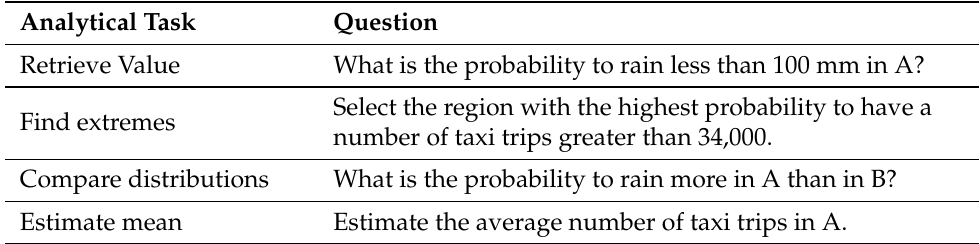
Table 1. Example of questions in the user